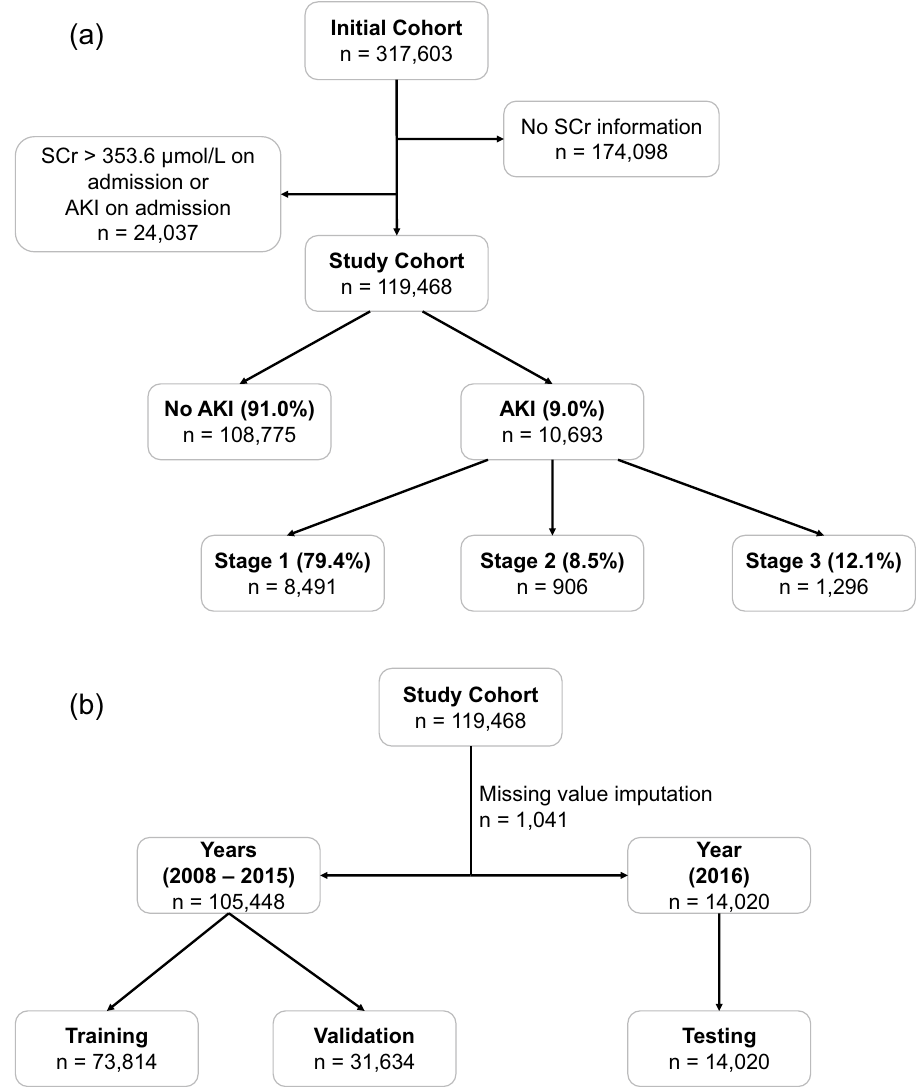
Figure 1. Flowcharts of ( a ) patient selection, and ( b ) splitting of study cohort into training, validation and testing